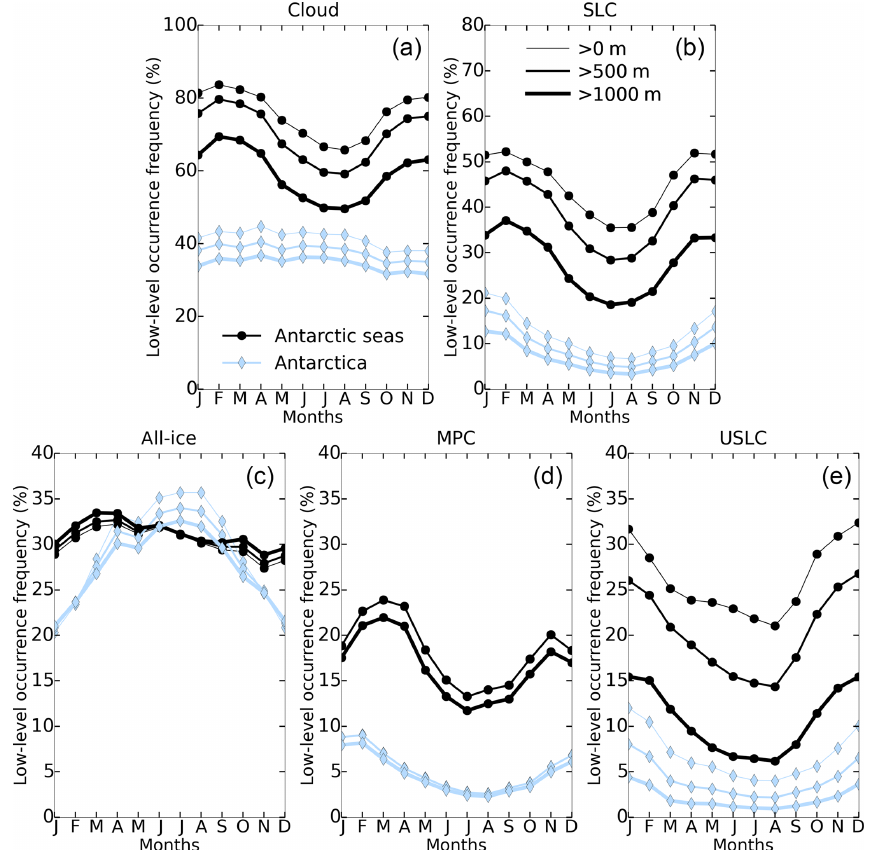
Figure B1. Monthly time series of the low-level cloud fraction (a) , SLC fraction (b) , all-ice fraction (c) , MPC fraction (d) and USLC fraction (e) for three different lower-altitude cut-offs: 0m (thinnest solid line), 500m (intermediate) and 1000m (thickest solid line). They are plotted by distinguishing between continental (blue lines) and marine (black lines) clouds. See Sect. 3.2 for the definitions of the